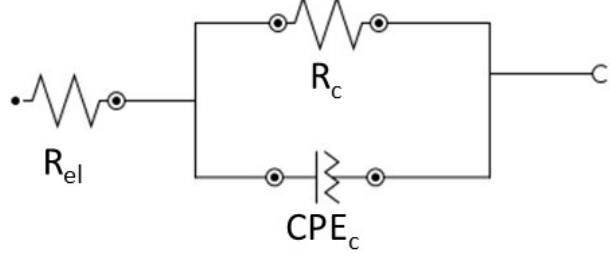
Figure 11. Equivalent circuit used for the analysis of electrochemical impedance spectroscopy (EIS) data. Table 3. Values of fitting analysis of the experimental EIS data employing the equivalent.